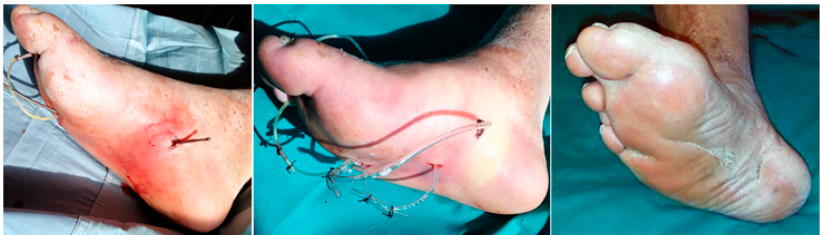
Figure 1. Extended plantar phlegmon. Left: With a probe, it is possible to follow the real spaces produced by the phlegmon spread along tissue plans. Where the end of the tract becomes superficial toward the skin, interposed tissues and the skin are pierced and incised in order to pass through the probe. Middle: A silastic tube is, thereafter, anchored to the probe in order to pass it backward along the fistula tract. Once this drainage is passed, the two ends are tied together with two silk stitches in order to construct the ulcer piercing ring (UP ring). Right: A diabetic foot ulceration (DFU) completely healed after 8 months in an out patient facility with daily medications and irrigations and with occasional antibiotic therapy and resulting with a small plantar scar. (Courtesy of Marco Cavallini).